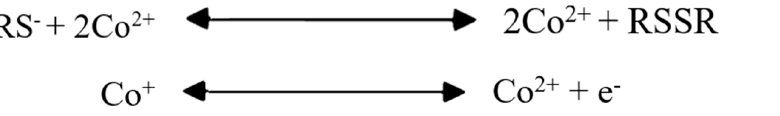
5 of 12 Figure 2. A plot of cyclic voltammetric peak current vs. pH for vitamin B1 in 0.1 M PBS. Figure 3. Scanning electron microscopy images of gold-coated working electrode of a CoPC-SPCE. Table 1. Energy dispersive X-ray microanalysis (EDX) of three individual CoPC-SPCEs. Element (% by Weight)